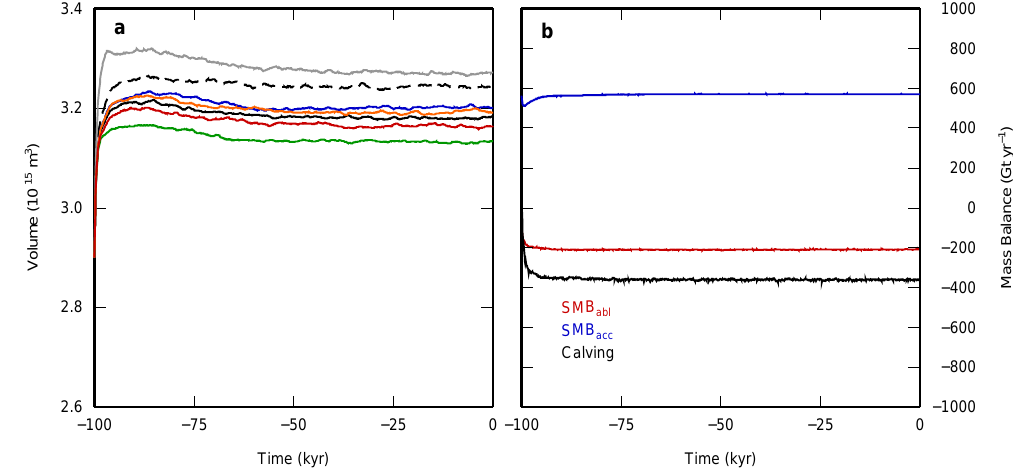
Fig. 8. Time series of (a) ice volume for experiments including (black solid line) and excluding (dashed line) refreezing, and using the PDD method (gray line) resulting from a constant climate forcing; using two different climate periods as a forcing results in the blue (pre-1990) and green (post-1990) curve; in- or decreasing the effect of refreezing on T s by 20% results in the red and orange curve, respectively; (b) mass balance components in the reference experiment (solid black line in panel a